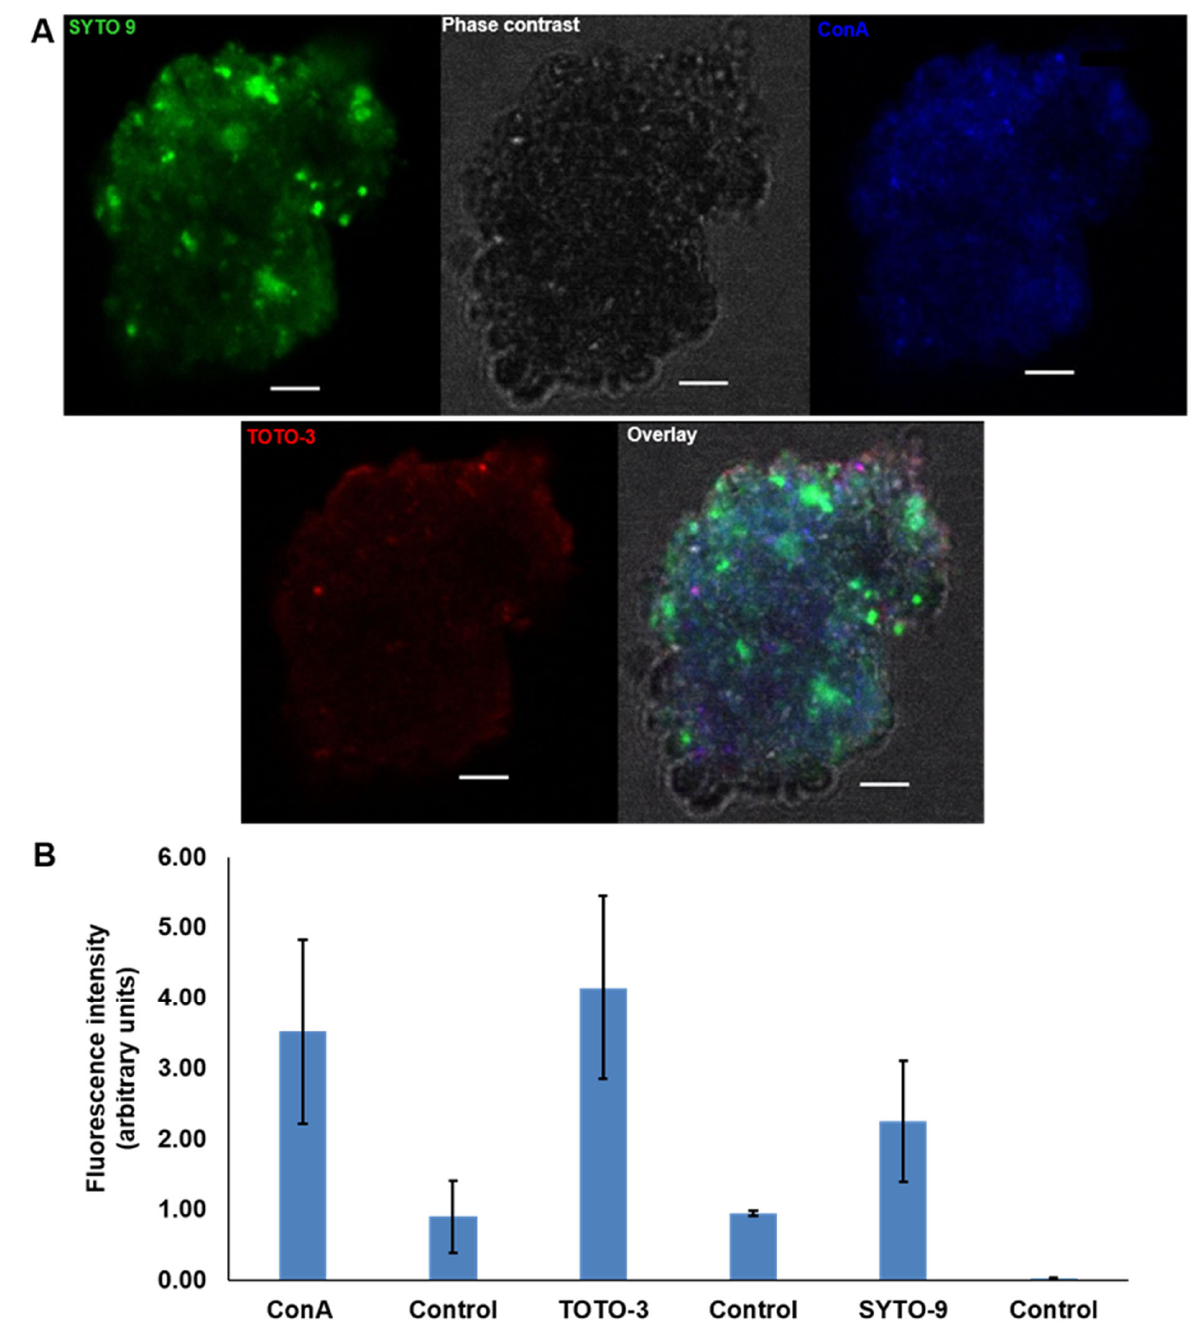
Figure 6. CLSM images of natural MGPs stained with TOTO-3 (red) to localise the presence of eDNA, SYTO 9 (green) for intracellular DNA and ConA (blue) for glycoproteins. Scale bar = 5 µm ( A ). Images acquired with Leica SP8 using 63 × objective. Quantification of the fluorescence intensity of each fluorophore against the control (unstained MGP) revealed high mean value of TOTO-3 indicating the presence of eDNA ( B ). The control is unstained particles. The graphs present the mean ± SD of 15 CLSM micrographs. Error bars represent the standard deviation of the data set ( n = 3), p < 0.05.